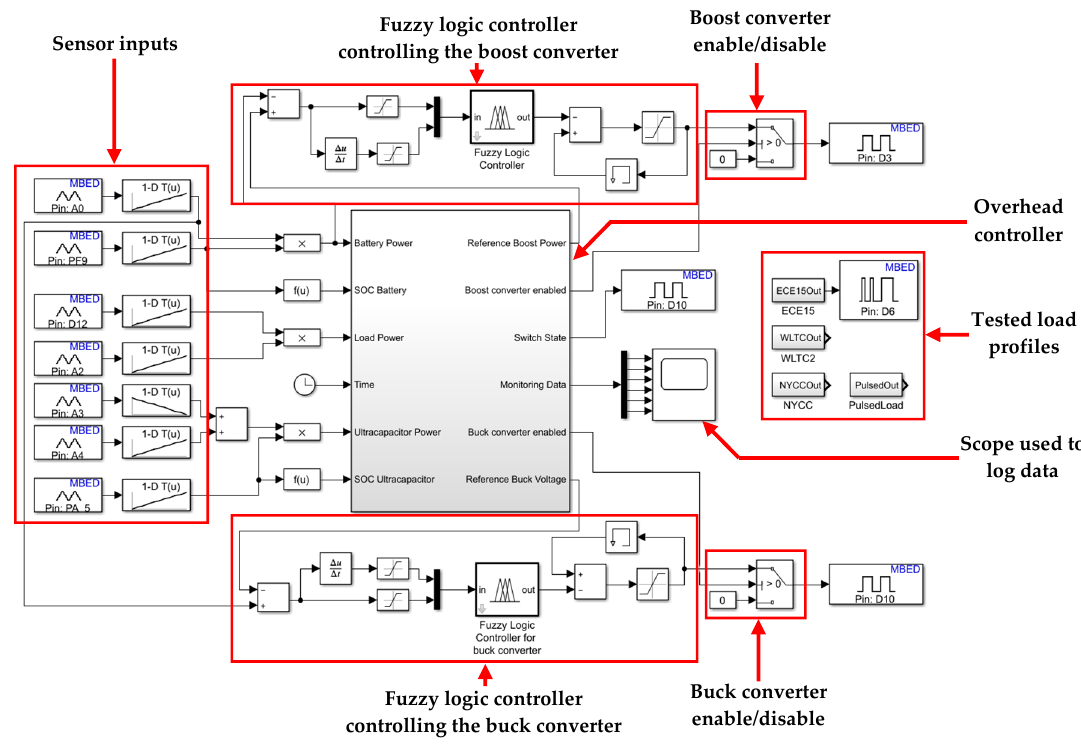
Figure 10. Experimental Simulink ® model.